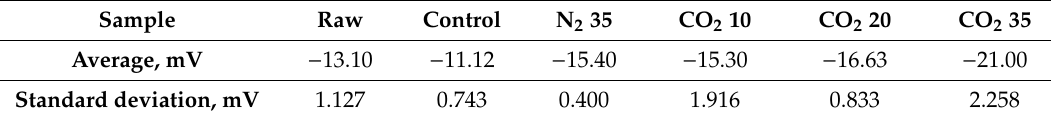
Table 2. Zeta potential of sludge particles treated by each HbQF treatment.